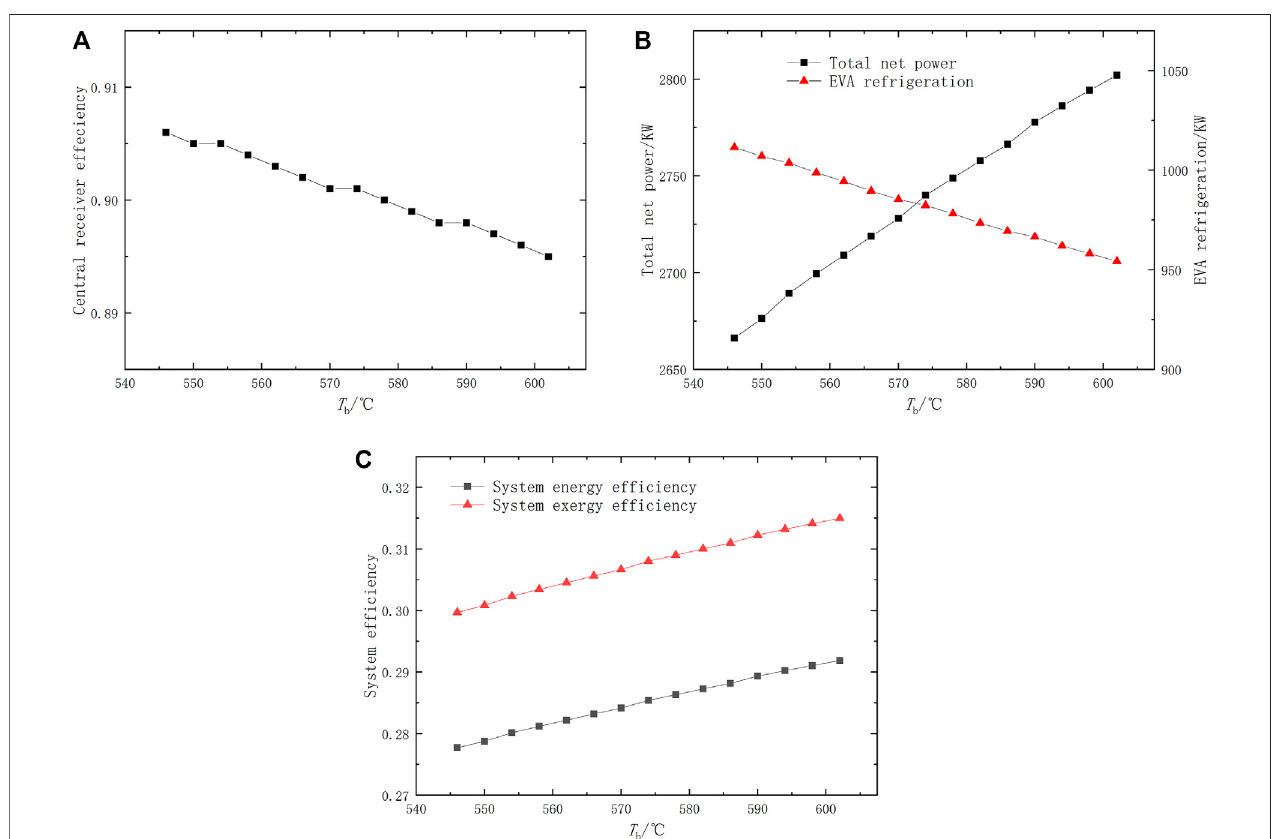
FIGURE 9 | Effect of molten salt outlet temperature T b